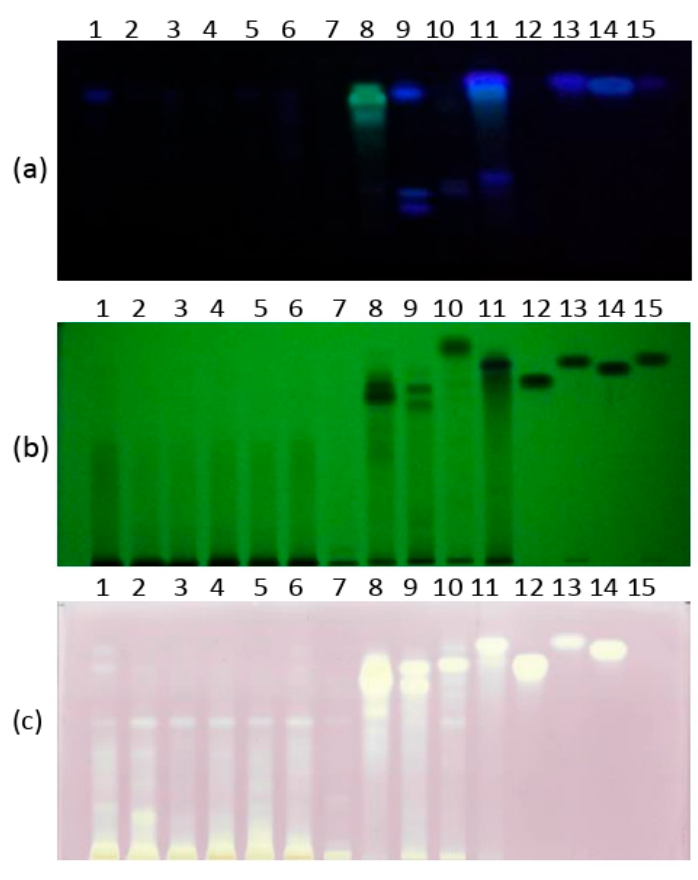
Figure 2. HPTLC chromatograms of samples: Q. robur (no. 1–3), Q. petraea (no. 4–6), Q. cerris (no. 7), Robinia pseudoacacia (no. 8), Prunus cerasifera (no. 9), Prunus avium (no. 10), mulberry (no. 11) and four standard compounds (gallic acid (no. 12), ferulic acid (no. 13), caffeic acid (no. 14) and p -coumaric acid(no. 15)); ( a ) under UV light at 366 nm; ( b ) under UV light at 254 nm; ( c ) DPPH-HPTLC